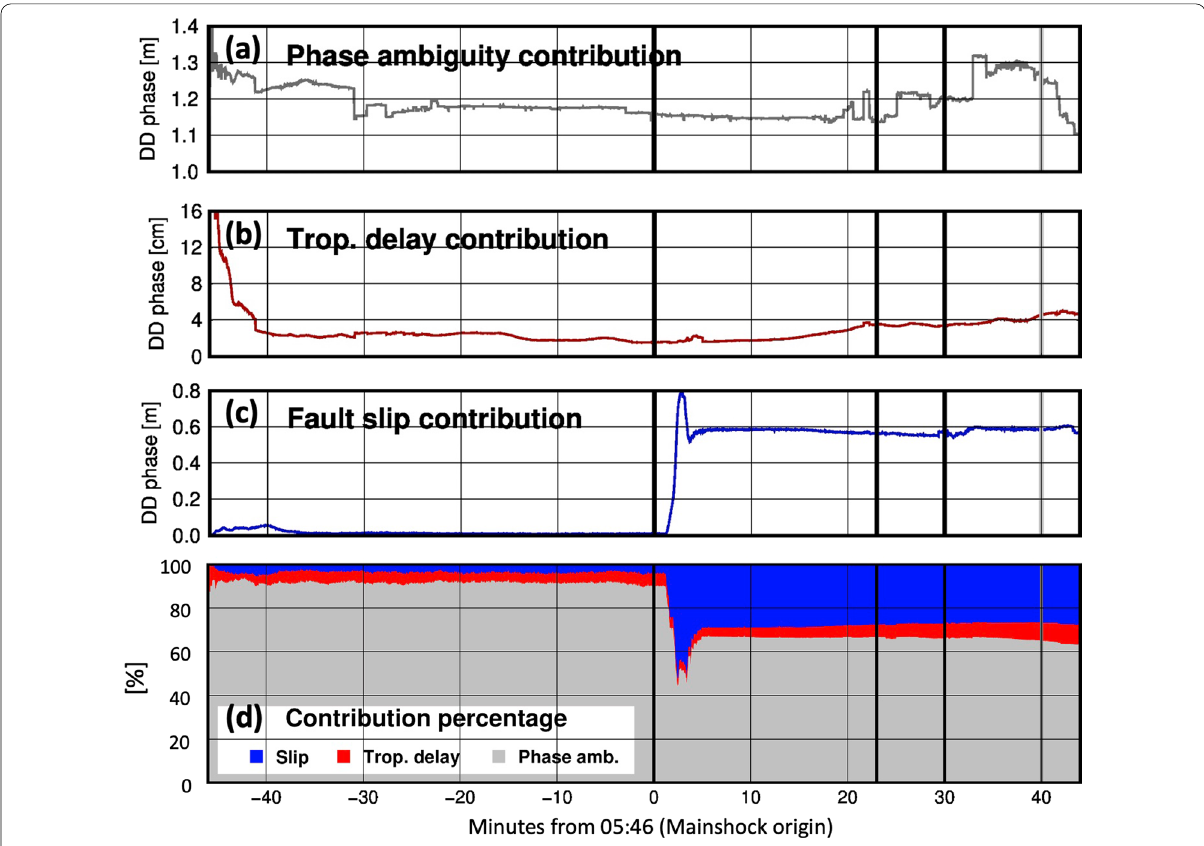
Fig. 9 Time evolution of the expected contribution of each unknown among the calculated carrier phase. The figures describe the average absolute value of contribution for all double difference. Four figures represent the contribution of phase ambiguity ( a ), tropospheric delay ( b ), fault slip ( c ), and their percentage among total calculated carrier phase ( d ). The vertical width of the three colored regions in ( d ) represents the percentage of each unknown. Please note that the contribution of ionospheric delay is not present here because we removed it using dual-frequency combination. Refer to Additional file 2 for the calculation of these contribution